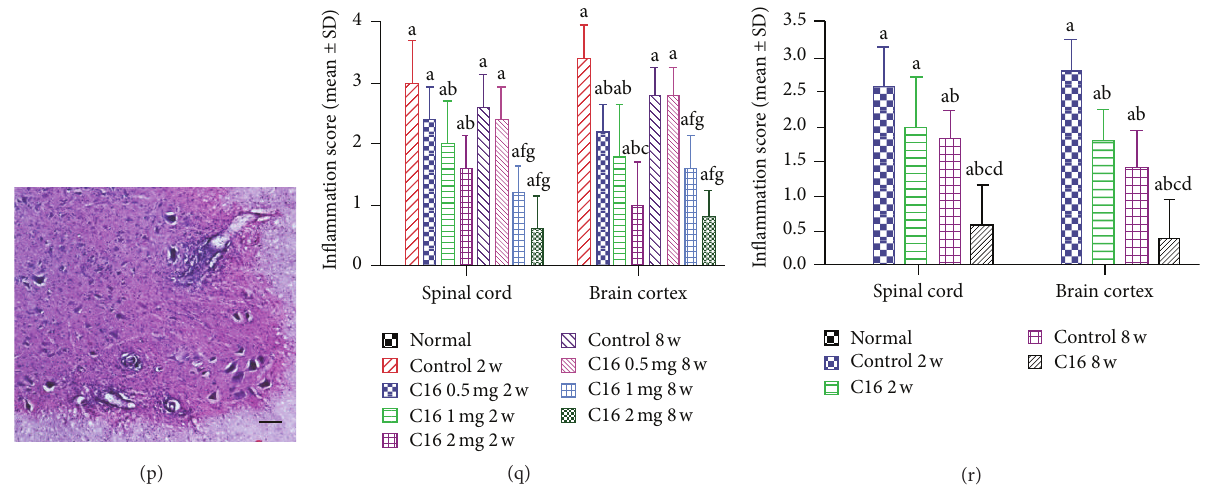
Figure 1: The appearance of lesion site in each group observed with MRI scanning was in accord with the severity of inflammatory cells infiltration showed by H&E staining: bar = 100 𝜇 m. (a) Normal group, T 2 W image of brain, without detectable changes occuring in the white matter. (b) The same animal as in (a). Histological staining. (c) Vehicle control rats at week 2 after immunization, T 2 W image. An arrow indicates clear hyperintensity area in the white matter. (d) The same animal as in (c). H&E staining, an arrow shows abundant cellular infiltrates under meninges. (e) 0.5 mg/day C16 treated EAE rats at week 2 after immunization. T 2 W image, an arrow showed a focal area with increased intensity. (f) The same animal as in (e). H&E staining. The arrow denotes “perivascular cuffing” of inflammatory cells. (g) C16 late treated EAE rats at week 2 after immunization. T 2 W image, an increased intensity lesion area was defined by arrow. (h) The same animal as in (g). H&E staining. (i) At week 8 after immunization. T 2 W image, arrow denotes an increased intensity lesion area, the same animal as in (j). H&E staining showed less severe inflammatory cell infiltration, and a lesion area was found at week 8 smaller than that at week 2 after immunization. (k) 2 mg/day C16 treated EAE rats at week 8 after immunization, T 2 W image. (l) The same animal as in (k). H&E staining. ((m)–(p)) Diffuse infiltration of inflammatory cells was observed in the spinal cord of the vehicle control rats, and attenuated in C16 treated EAE rats at week 2 after immunization. H&E staining, traverse section through the lumbar spinal cord; bar = 100 𝜇 m. Normal rats group (m), vehicle control rats (n), 2 mg /day C16 treated EAE rats (o), and C16 late treated EAE rats (p). (q) Medium and high dose C16 treatment reduced inflammatory cells showed by inflammation score. a 𝑃 < 0.05 versus normal rats; b 𝑃 < 0.05 versus vehicle control rats at week 2 postimmunization group; f 𝑃 < 0.05 versus vehicle control rats; g 𝑃 < 0.05 versus 0.5 mg/day C16 treated EAE rats at week 8 after immunization. (r) C16 late treatment also inhibited inflammatory cells infiltration to a certain extent showed by inflammation score. a 𝑃 < 0.05 versus normal rats; b 𝑃 < 0.05 versus vehicle control rats at week 2 after immunization; c 𝑃 < 0.05 versus C16 treated EAE rats at week 2 postimmunization group; d 𝑃 < 0.05 versus vehicle control rats at week 8 after